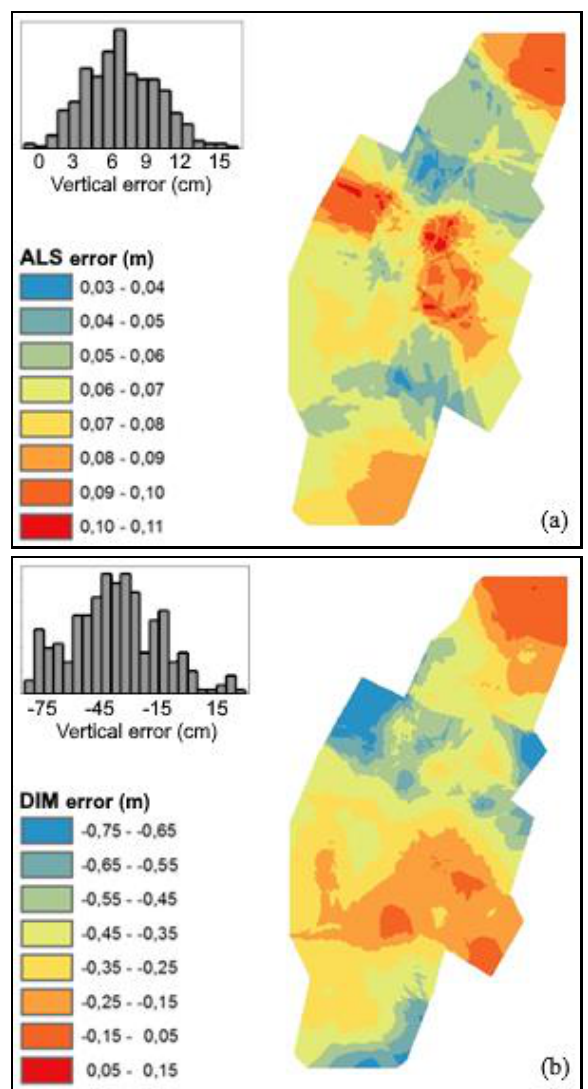
Figure 2 – Vertical error assessment: Kriging results and respective histogram. ALS (a) and DIM (b) point clouds.